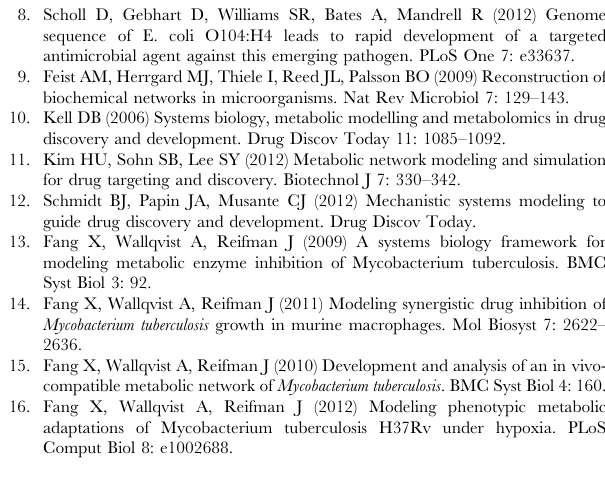
Figure S1 Growth curves for the six active compounds. Table S1 Essential metabolic genes. The F.